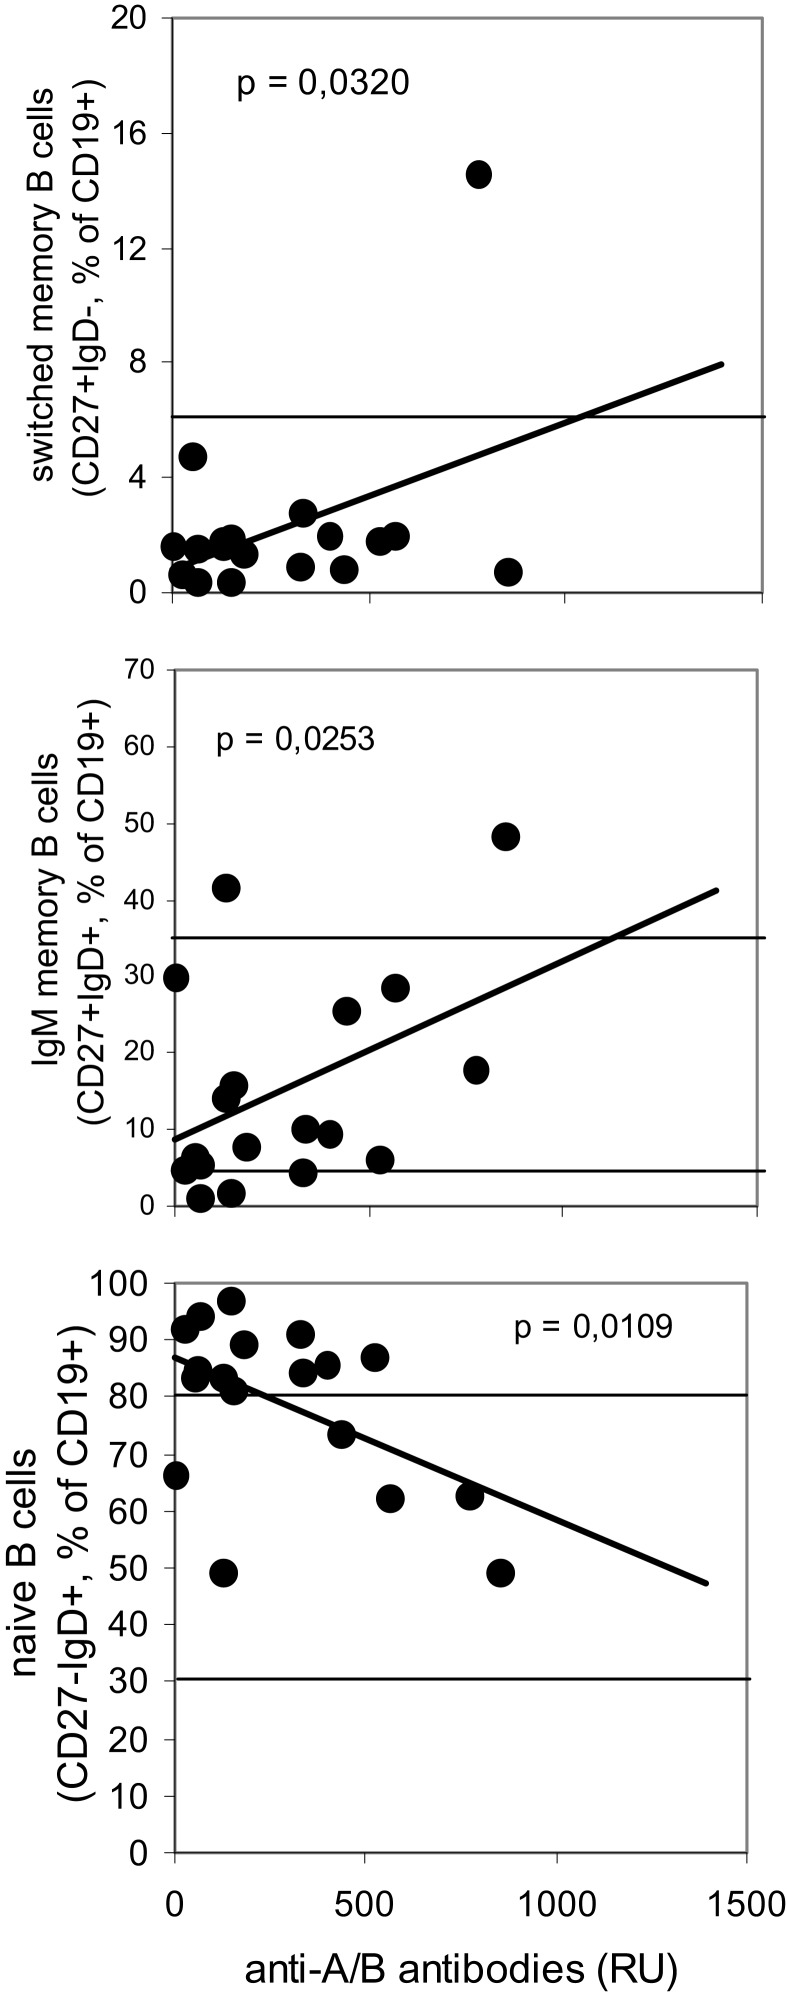
Correlation between levels of anti-A/B antibodies as detected by surface plasmon resonance using the Biacore® device and levels of B cell subsets in CVID patients. Anti-A/B antibodies were determined using surface plasmon resonance (SPR) technology with synthetic blood group A/B trisaccharides coupled to the CM-5 Biacore® chip by amine binding, antibody titers are expressed as resonance units (RU). Peripheral B cell subsets were determined by three-color-flow cytometry, results are depicted as the percentage of total number of CD19+ B lymphocytes. Horizontal lines indicate the normal range of B cell subsets as determined in 134 healthy individuals (upper panel: 5th percentile; middle and lower panel: upper line, 95th percentile, lower line, 5th percentile). The Bravais–Pearson-correlation coefficient was calculated to determine a statistically significant correlation between two parameters at a level ofP < 0.05.